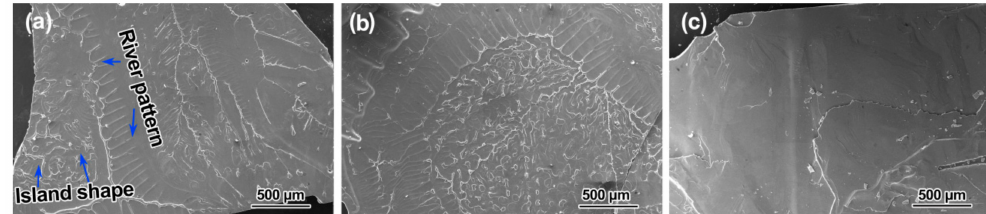
Figure 5. Morphologies of the primary Si at the side interface: ( a ) without RMF, ( b ) 600 mT SMF and ( c ) 25 mT